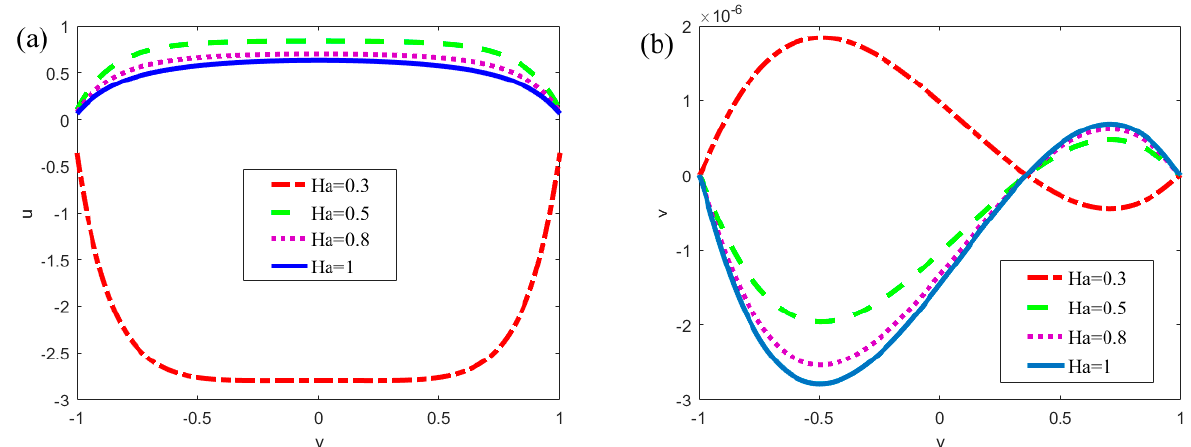
Figure 7. The dimensionless velocity at different positions varies with the Hartmann number Ha ( x = π /4, m = 0.5, n = 0.8, κ = 7, α = 5, β = 5, ξ 1 = 0.02, ξ 2 = 0.02, δ = 0.02, u r = 1, R = 1). ( a ) velocity u ; ( b ) velocity v .